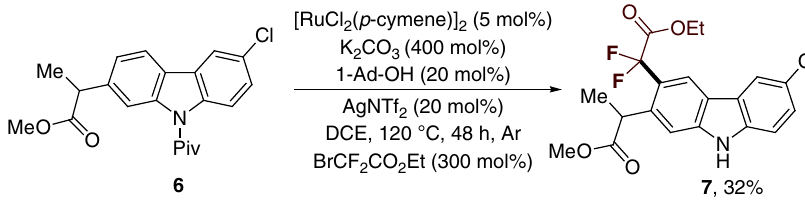
Fig. 3 The application in organic synthesis. Synthesis of a carprofen